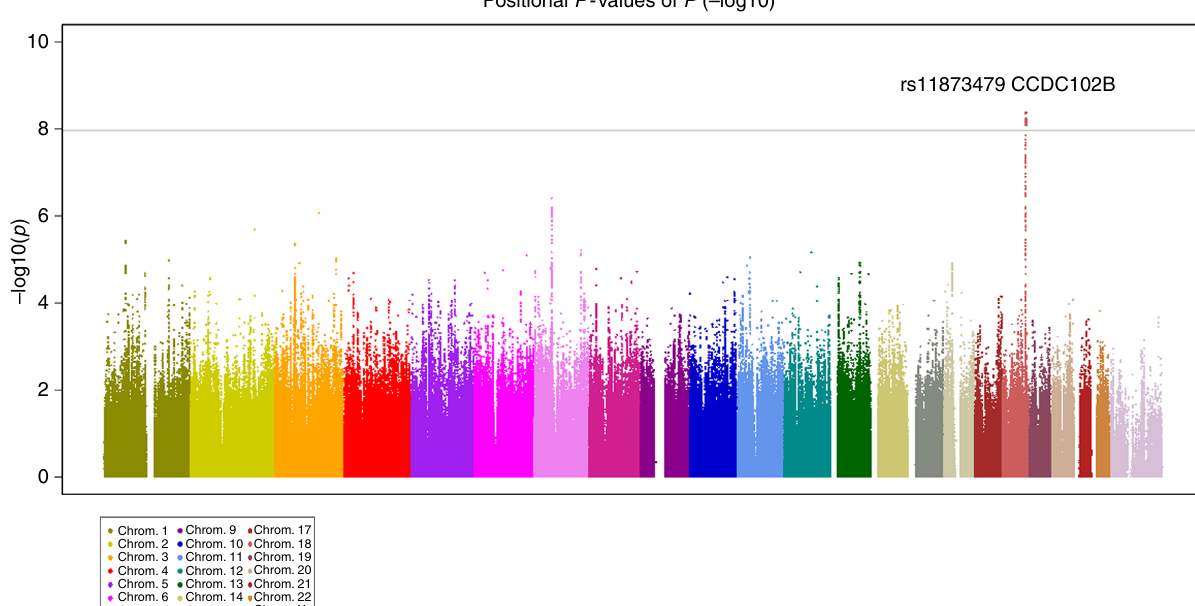
Fig. 1 Manhattan plot of case-control GWAS on myopic maculopathy. Each plot shows − log 10 -transformed P values for all SNPs adjusted for age, sex, and axial length. The horizontal line represents the genome-wide signi fi cance threshold of 1.06 × 10 − 8 . GWAS, genome-wide association